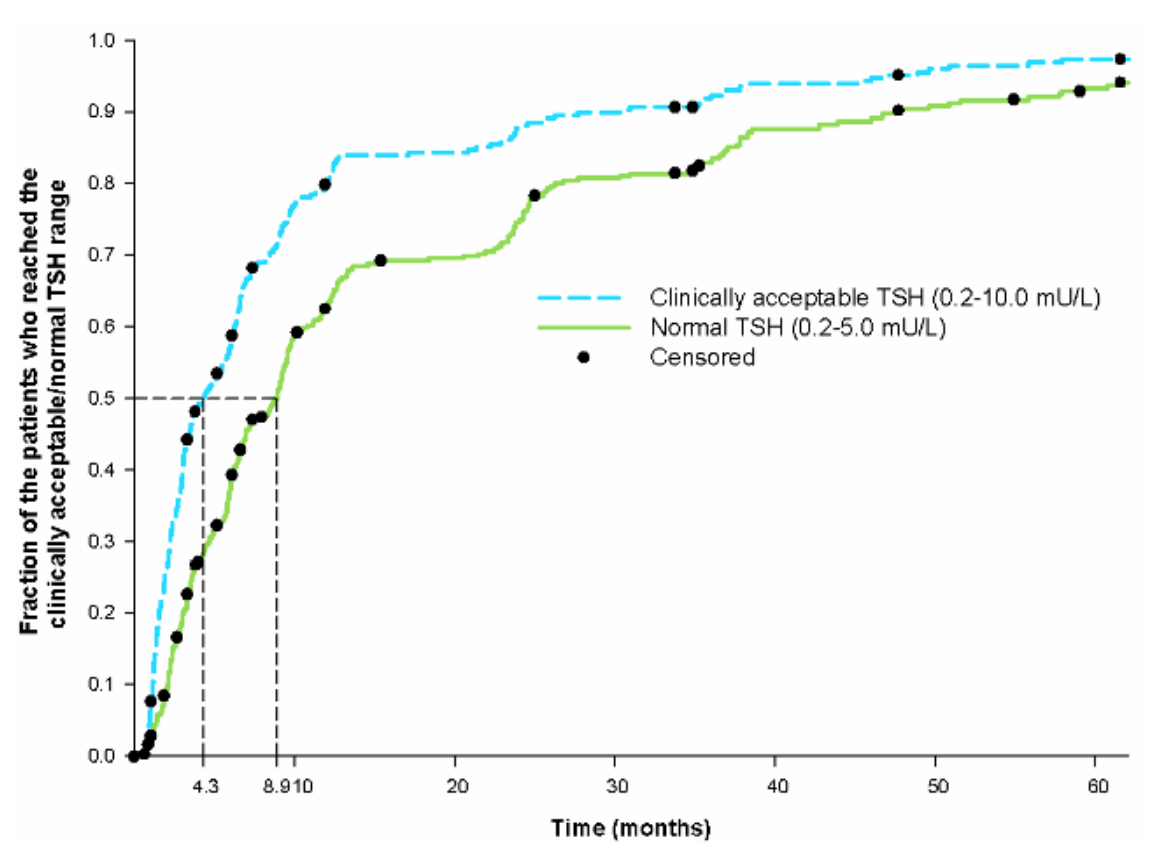
Figure 3: Kaplan Meier curves for the fraction of patients who had a TFT performed within the clinically acceptable and normal TSH range, respectively. Censoring is indicated by the black dot tic mark. For visual purpose the figure does not show the entire follow-up period (11 years). Therefore, few cases are not shown in the figure due to very late occurring normalization. 1 case was left out on the clinically acceptable curve (time 121.9 months). 3 cases were left out on the normal TSH curve (time 117.9, 121.9 and 122.1 months). On the clinically acceptable curve, only the 272 patients who had TSH ≥10 mU/L at diagnosis are